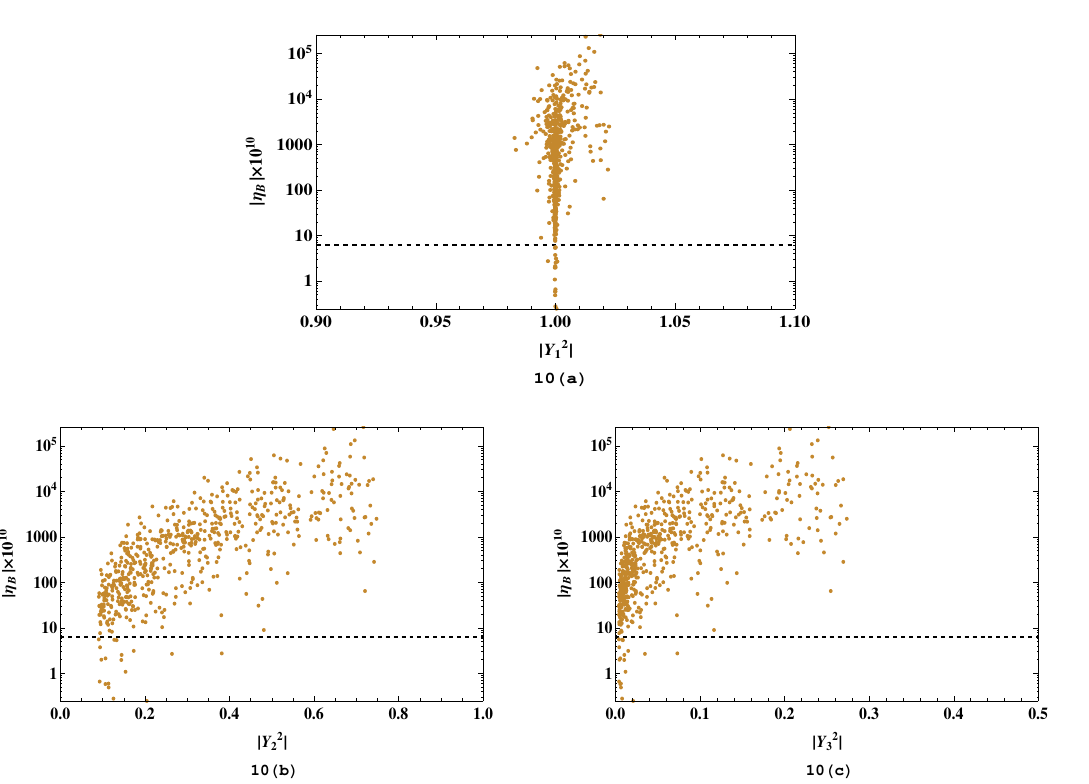
Figure 10 . Variation of baryon asymmetry with absolute value of Yukawa couplings of modular weight 2 ( | Y 2 | , | Y 2 | , | Y 2 | ) for normal hierarchy. Dashed line denotes the value observed baryon 1 2 3 asymmetry | η = (6 . 12 ± 0 . 04) × 10 − 10 B |